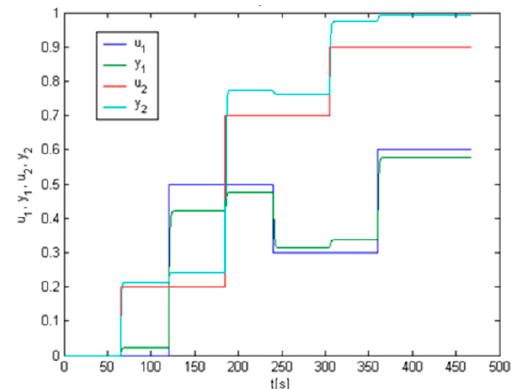
Figure 5. System response (green and cyan) on the given set-points (blue and red).